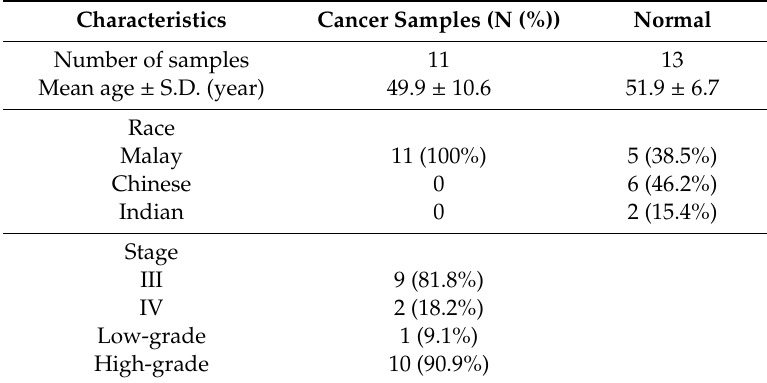
Table 1. The patient information of the ovarian tissue samples used in the